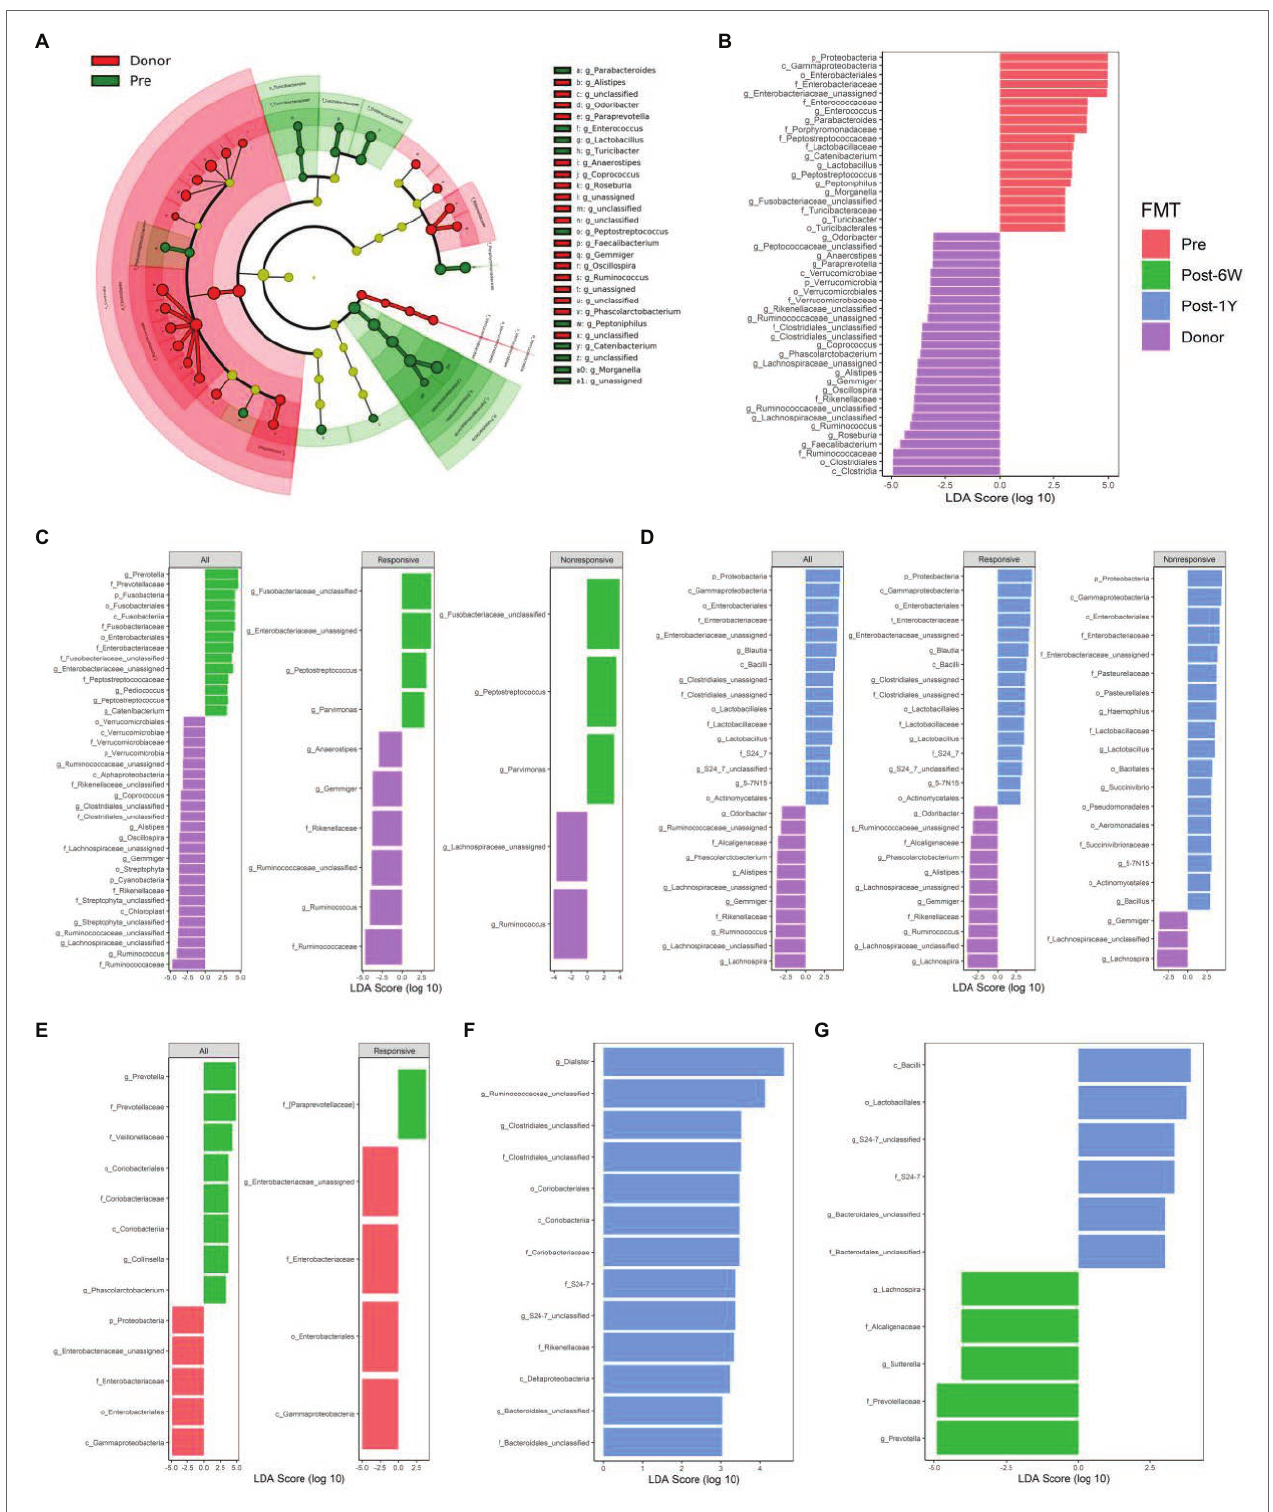
FIGURE 5 | Comparison of differential taxonomic features at different time points. (A) The cladograms of differential taxa between UC patients and donors before FMT. Histograms of the LDA scores for taxonomic features differentially abundant between patients before FMT and donor (B) , patients 6 weeks after FMT and donor (C) , patients 1 year after FMT and donor (D) , patients before FMT and 6 weeks after FMT (E) , patients before FMT and 1 year after FMT (F) , and patients 6 weeks after FMT and 1 year after FMT (G)